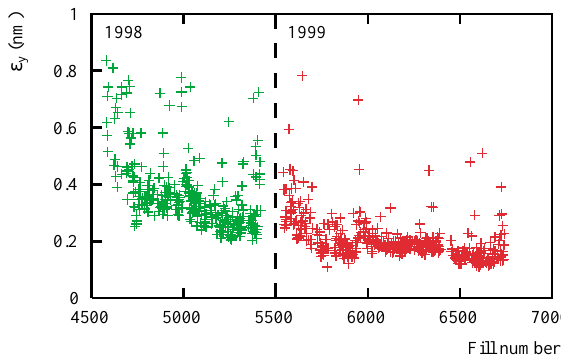
FIG. 9. (Color) Average vertical beam emittance in collision for bunch currents of 500 to 550 m A for each LEP fill in 1998 and 1999. The emittance is extracted from the measured luminosity.